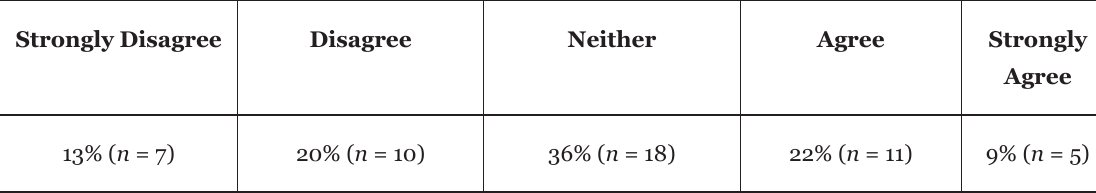
Responses to the Question about Frustration Level about Having to Learn a New LMS